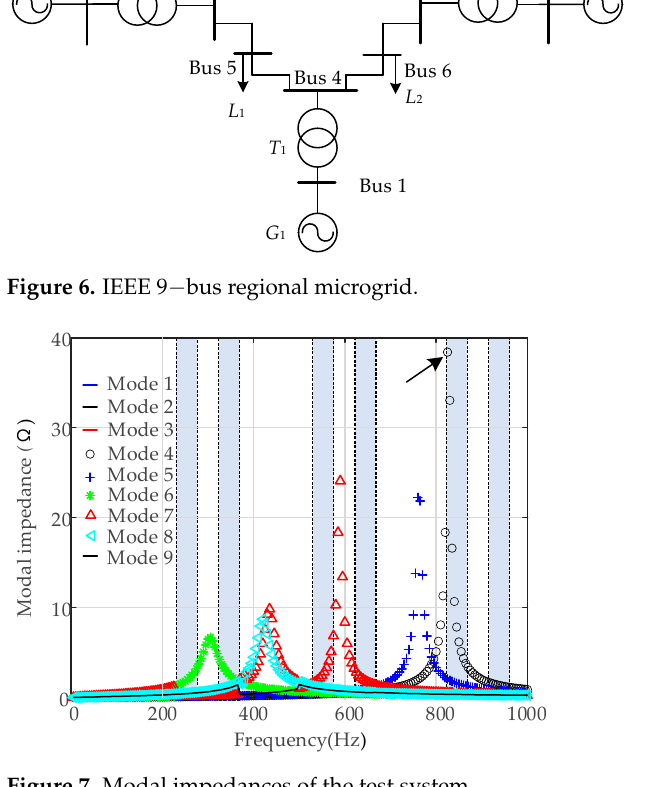
Figure 7. Modal impedances of the test system.